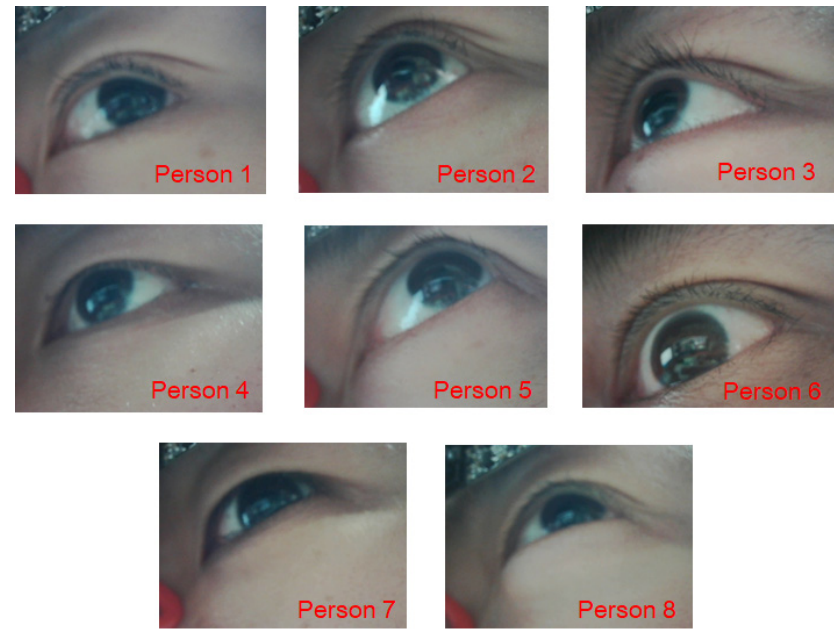
Figure 5. Collected datasets of nearfield visible-light eye images.